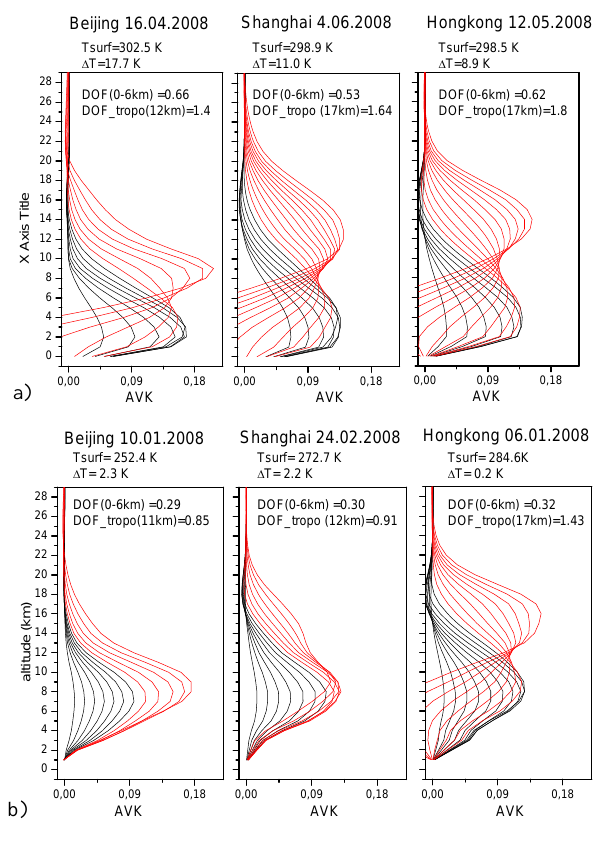
Fig. 2. Example of tropospheric averaging kernels derived from IASI observations above Beijing, Shanghai and Hong Kong a) for favourable thermal conditions (spring) and b) for unfavourable thermal conditions (winter). The retrieved effective surface temperature, thermal contrast and the degrees of freedom up to 6 km and up to the tropopause height are indicated for each case. The averaging kernels are given for the retrieval grid (1 km spacing). They are represented in black for the levels up to 6 km and in red for the levels above.